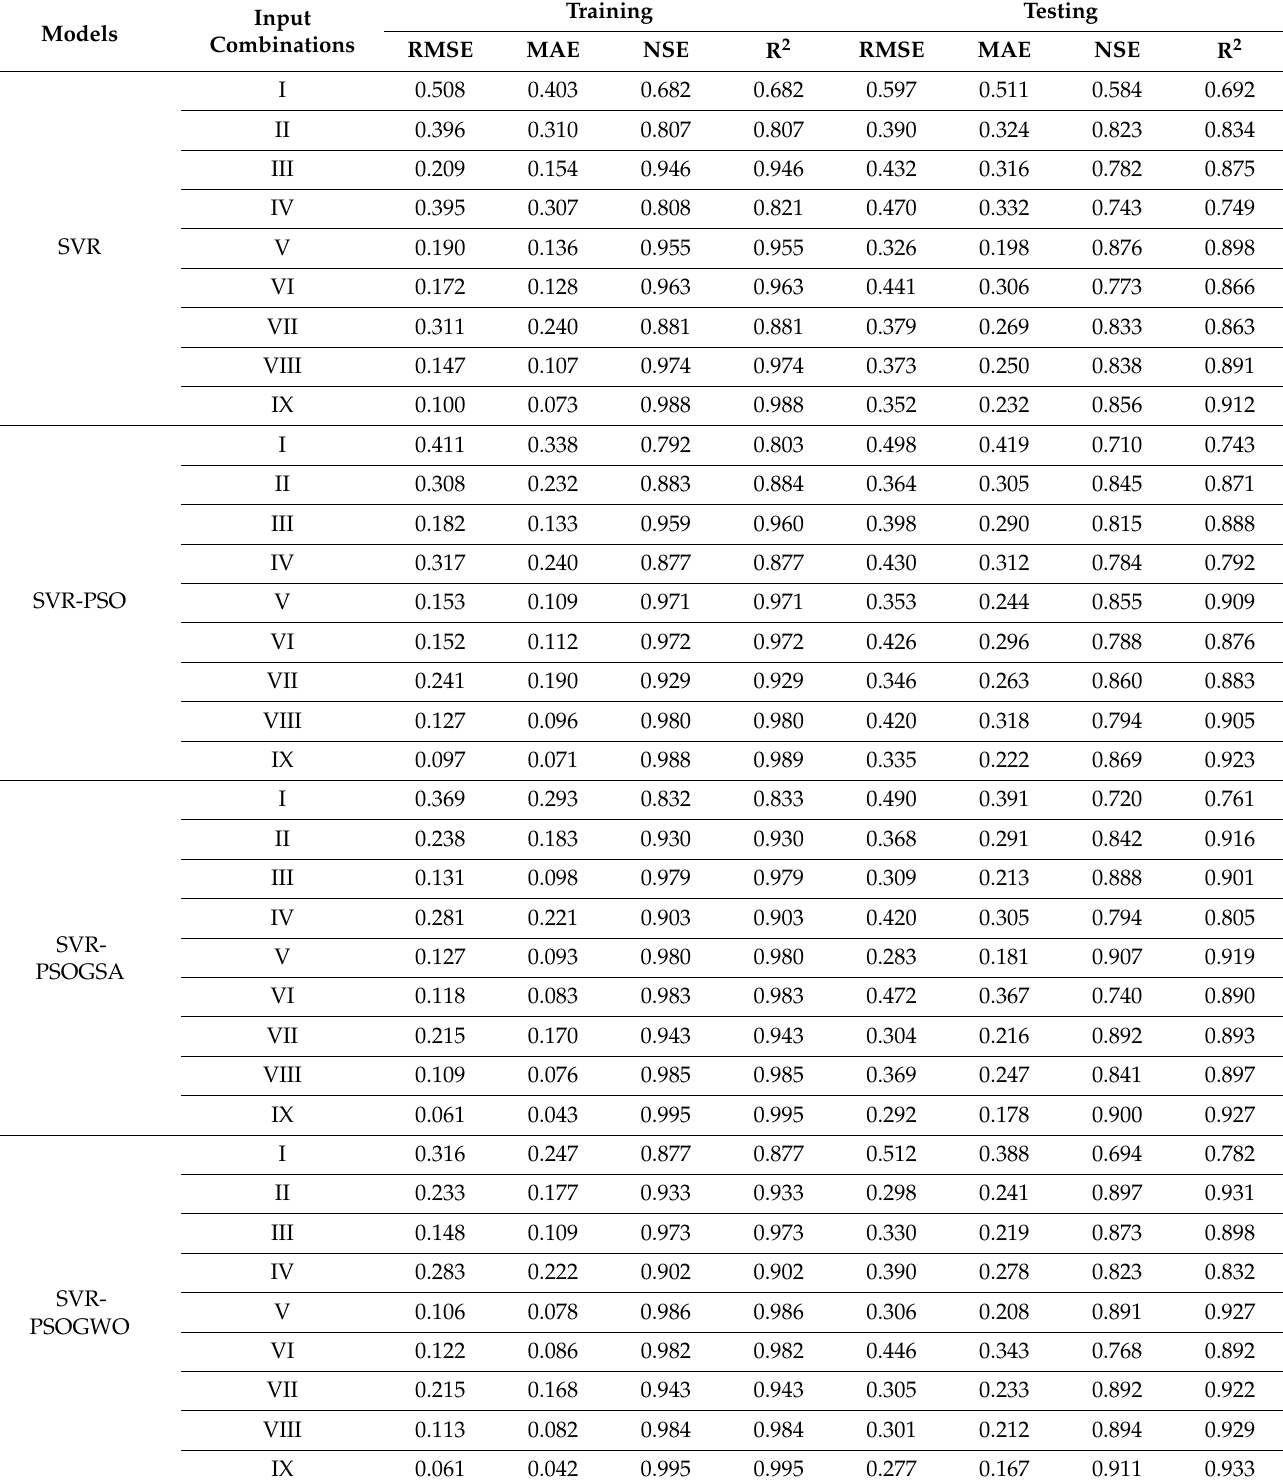
Table 4. The results of Station 1 (Bogra) using SVR-based